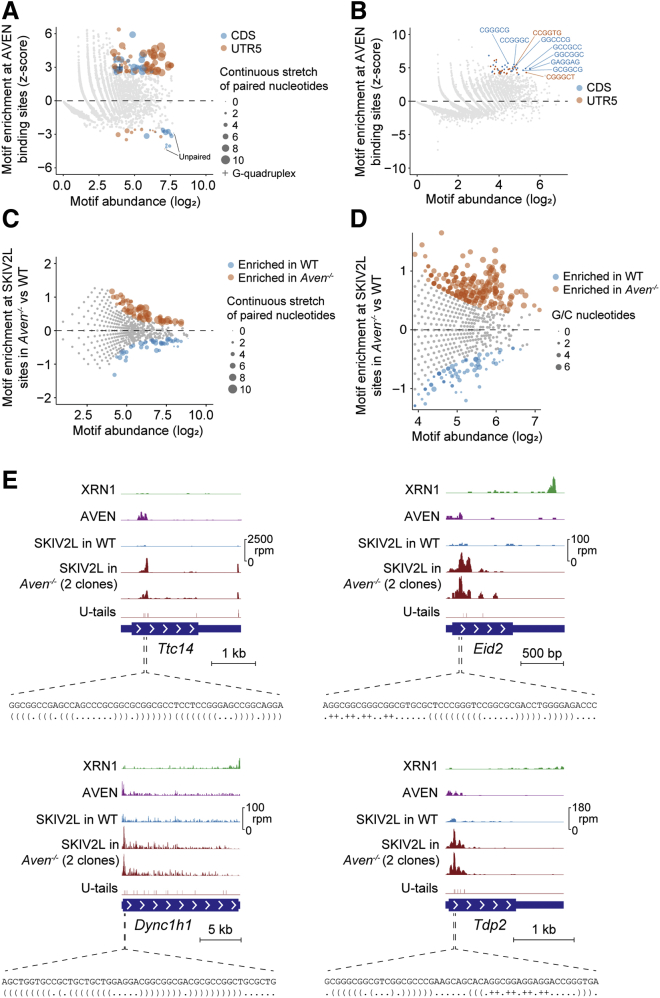
AVEN Acts on Structured RNAs(A and B) Structure (A) and sequence motif analysis (B) for AVEN-binding sites, based on CRAC versus RNA-seq enrichments in 50-nt 5′ UTR and CDS windows. Points (structure motifs) in (A) are scaled by paired nucleotide content.(C and D) Structure (C) and sequence motif analysis (D) for SKIV2L binding sites, comparing Aven−/− and WT cells. Points in (C) are scaled as for (A), and points in (D) are scaled by GC content.(E) Examples of AVEN-bound windows showing their sequence, predicted structure (bracket/dot annotation for paired/unpaired nucleotides; + = G-quadruplex), and CRAC coverage for various proteins.See also Figure S5.